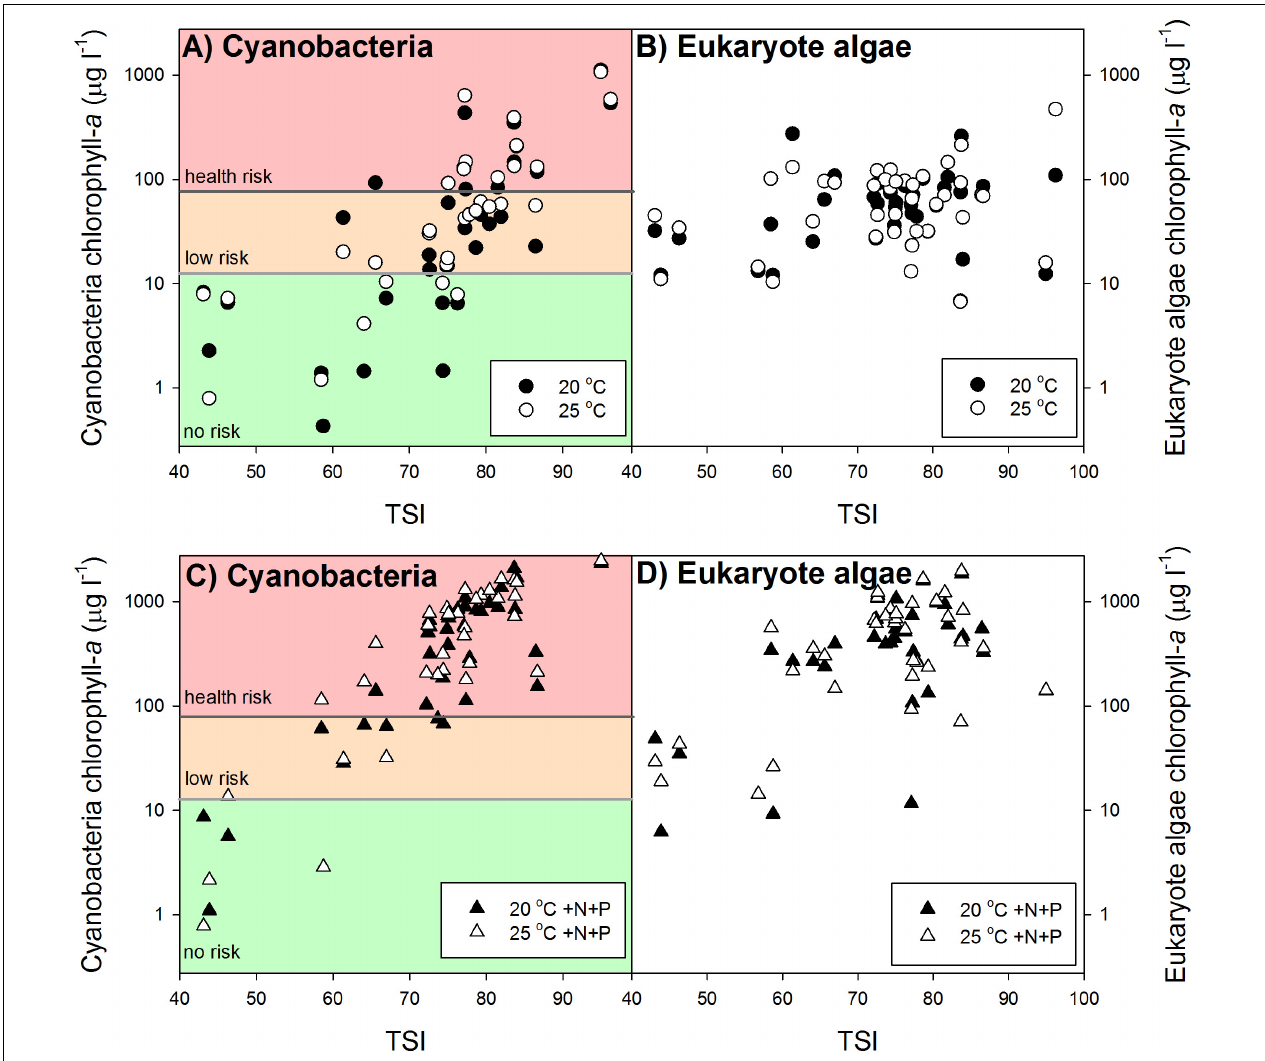
FIGURE 2 | Mean cyanobacterial (left panels A,C ) and eukaryote phytoplankton (right panels B,D ) chlorophyll-a concentrations ( µ g l − 1 ) in samples from surface waters varying in trophic state (TSI) after one week incubation at 20 ◦ C (filled circles), 25 ◦ C (open circles), 20 ◦ C with additional nutrients (N and P) added (20 ◦ C +N+P; filled triangles) and at 25 ◦ C with additional nutrients added (25 ◦ C +N+P; open triangles). In the cyanobacteria panels the colored backgrounds indicate the different chlorophyll-a based risk levels according to the Dutch cyanobacteria protocol (Ibelings et al., 2012). Green = no risk ( < 12.5 µ g l − 1 ), orange = low risk (12.5–75 µ g l − 1 ), and red = health risk ( > 75 µ g l − 1